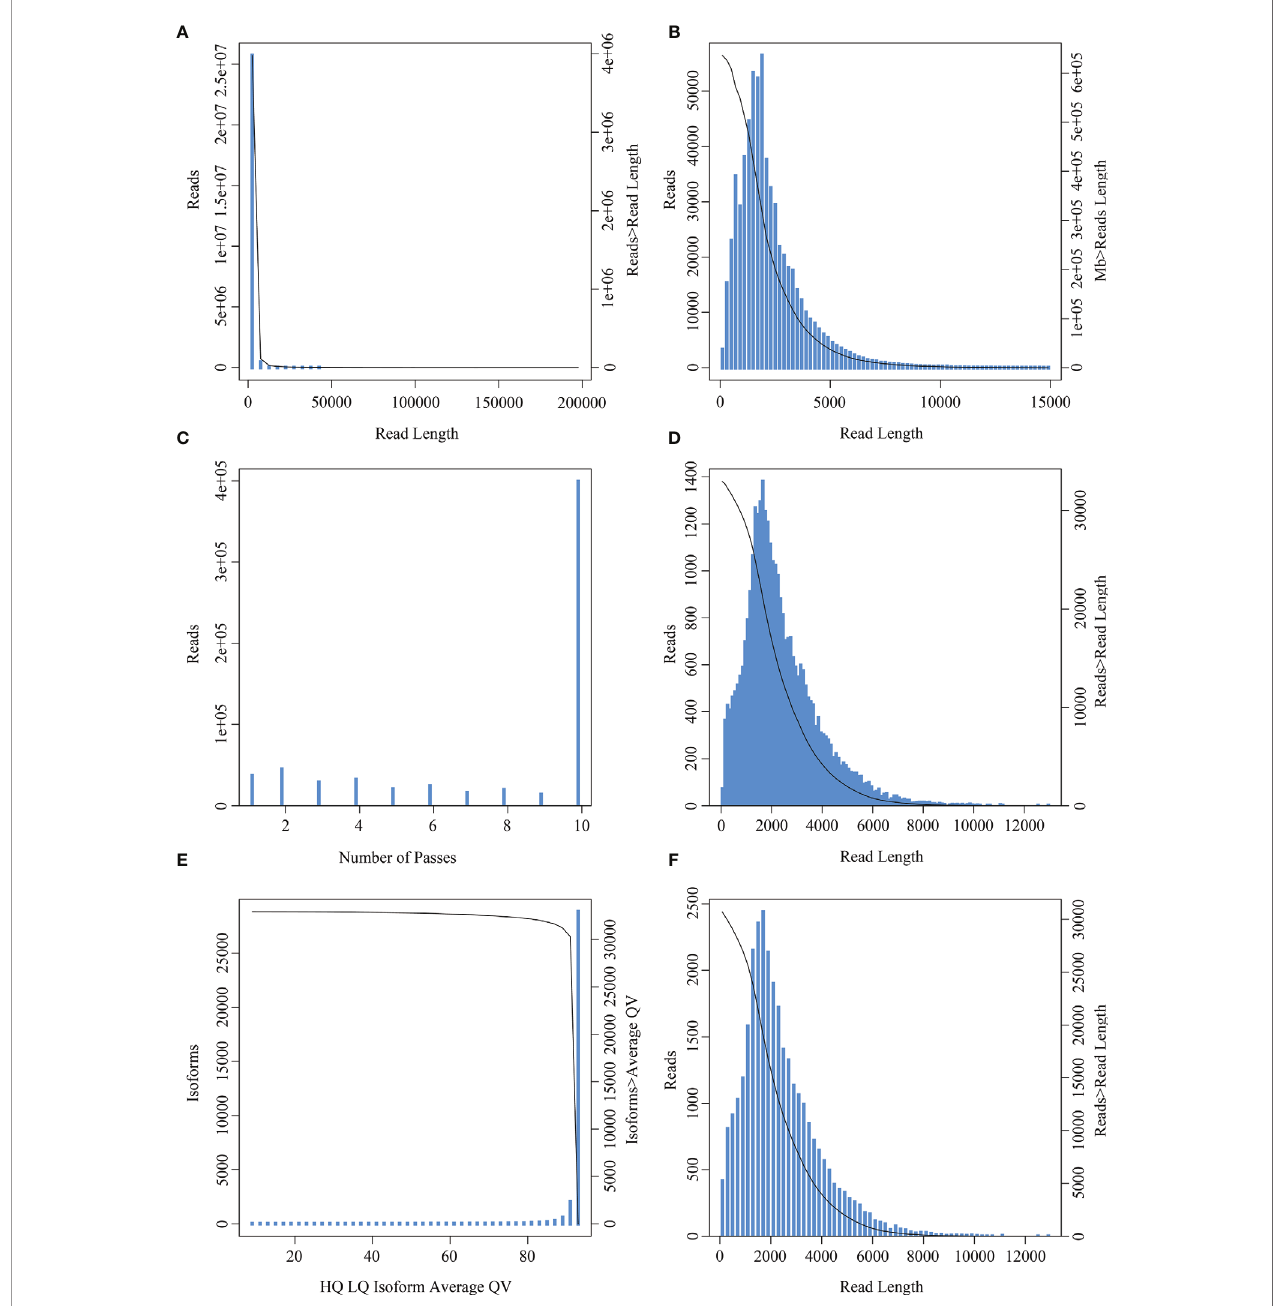
FIGURE 3 | Read number and length distribution after full length transcriptomic sequencing. (A) Subread length distribution: the abscissa represents the length of subreads, and the ordinate is the number of subreads. (B) CCS length distribution: the x-axis represents the length of the reads, and the y-axis on the left represents the coordinates of the column graph, indicating the number of reads whose length is within a certain range (x-axis); the y-axis on the right is the coordinate of the graph, indicating the number of reads whose length is greater than a certain value (x-axis). (C) CCS passes distribution: the abscissa represents the number of full passes and the ordinate represents the number of CCS sequences with corresponding full passes. (D) Consistent sequence length distribution: the abscissa represents the length of the consistent sequence, the left ordinate represents the number of sequences with the length, and the right ordinate represents the number of sequences with the length greater than a certain value (x-axis). (E) Mean mass distribution map of consistency series: the abscissa represents the quality values of high- and low-quality sequences, and the ordinate represents the number of consistent sequences of the respective quality values. (F) Isoform length distribution: the x-axis represents the length of isoforms, and the y-axis on the left represents the coordinate of the column graph, representing the number of isoforms whose length is within a certain range (x-axis); the y-axis on the right is the coordinate of the graph, indicating the number of isoforms whose length is greater than a certain value